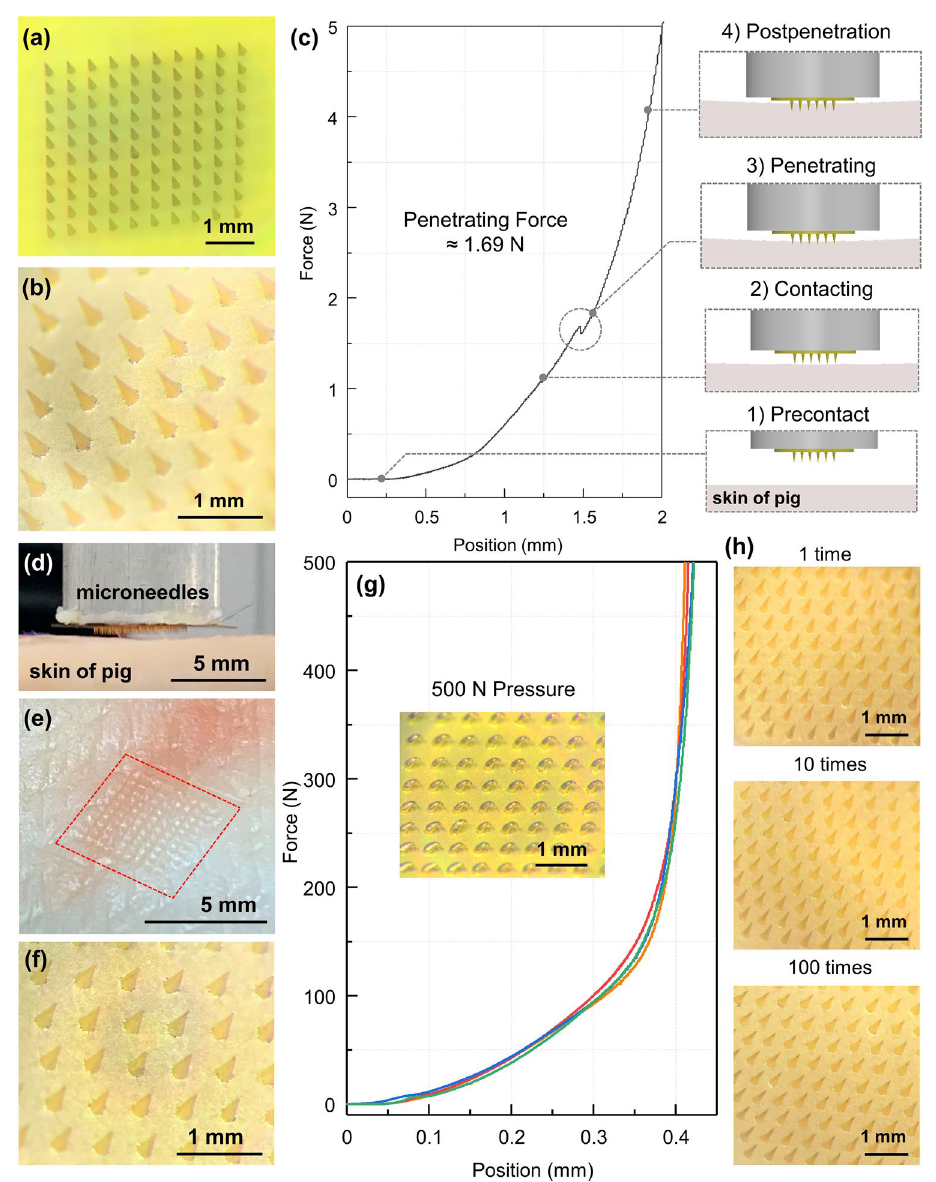
Fig. 3 Micrographs of a the master mold after repeatedly micromolding for 25 times and b the PI-MNA electrode fabricated from the 25th micromolding of the same master mold. c Pressure–displacement curve tested during the PI-MNA electrode application to a piece of pig skin and the schematic diagrams when precontact, contacting, penetrating, and postpenetration. d Photographs of the penetration test. e Micrographs of the surface of pig skin after PI-MNA electrode penetration and f the surface of the PI-MNA electrode after penetrating the pig skin at 5 N pressure. g Pressure–displacement curves of force applied to the PI-MNA electrode up to 500 N through a rigid pressure probe (n = 4). Inset: micrograph of the microneedles after 500 N extrusion. h Micrographs of the PI-MNA electrode surface after multiple applications to human forearm